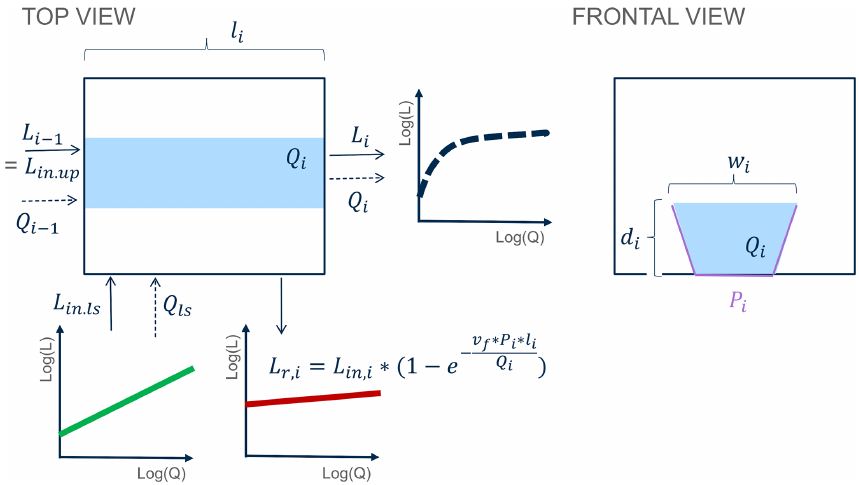
Figure B2. Network model, illustrated for one grid cell. Here, the flow length through a grid cell i is l i [L]; w i [L] and d i [L] are the respective width and average depth of the reach, and P i [L] is the corresponding stream channel wetted perimeter. The uptake velocity is denoted as v f . The local discharge Q i [L 3 T − 1 ] consists of upstream incoming discharge Q i − 1 [L 3 T − 1 ] and land-to-stream runoff Q ls [L 3 T − 1 ]. Similarly, the local load L [MT − 1 ] consists of upstream incoming load L in.up [MT − 1 ] and the land-to-stream load L in.ls [MT − 1 ], where L in. = L in.up + L in.ls . Finally, the local load removed is denoted as L r,i [MT − 1